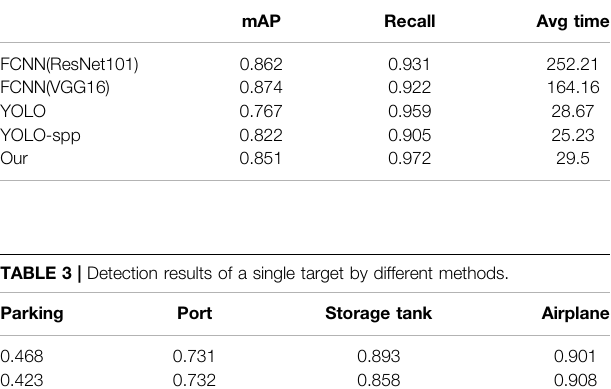
TABLE 2 | Test results of different methods.